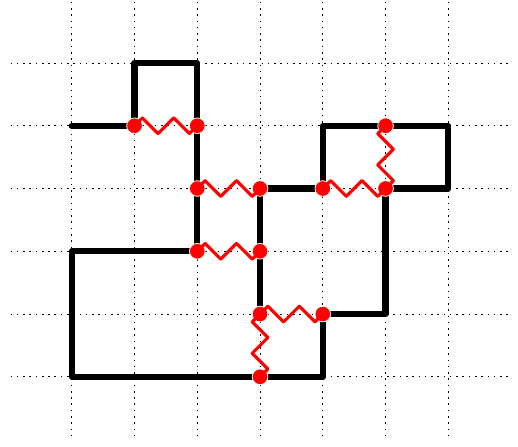
Fig. 5. An interacting self-avoiding walk on the square lattice with n = 26 steps and m = 7 contacts.